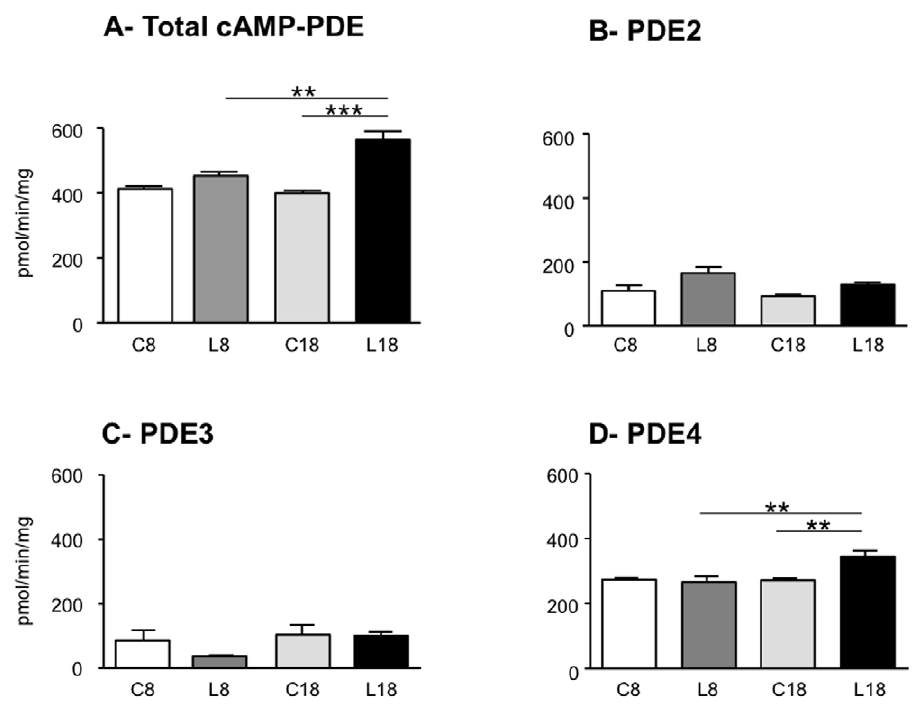
Figure 2. Evolution with the disease of cAMP-PDE activities in the kidneys of MRL/lpr mice. cAMP-PDE specific activities in total homogenate (A) and contribution of PDE2, PDE3 and PDE4 (B–D) were assessed on 8 week-old (C8) and 18 week-old (C18) CBA/J control mice and 8 week-old (L8) and 18 week-old (L18) MRL/lpr mice as described in the Methods section. Data are expressed as pmol/min/mg of protein and are the mean 6 s.e.m. of the data obtained from three individual mice. **, P , 0.01; ***, P , 0.001.